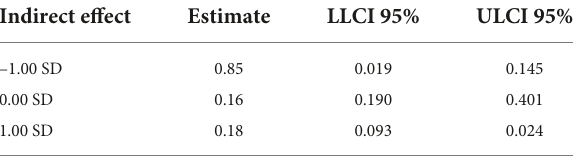
TABLE 3 Indirect effects at Age = M ± 1 SD.